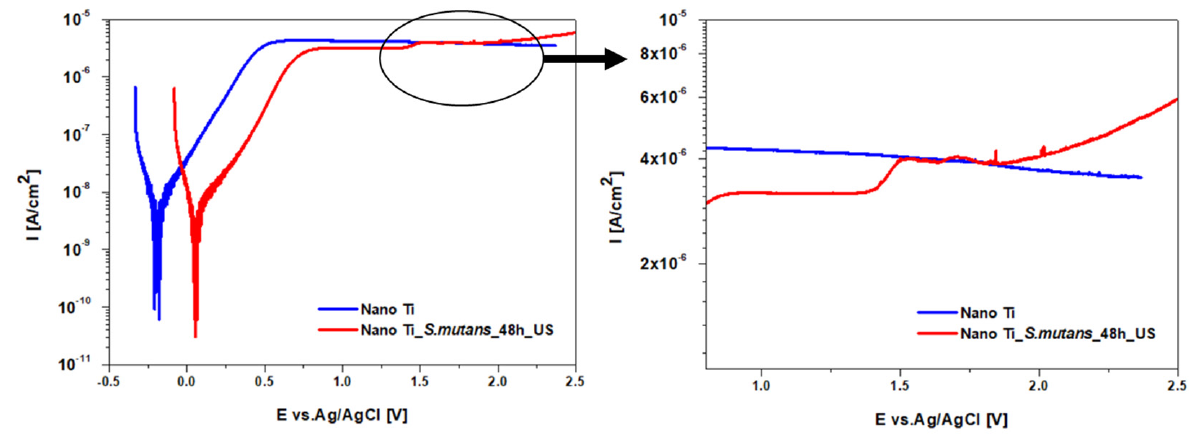
Figure 7. Corrosion resistance of nanostructured Ti in the polished state and after bacteria removal (electrochemical evaluation, PD tests).